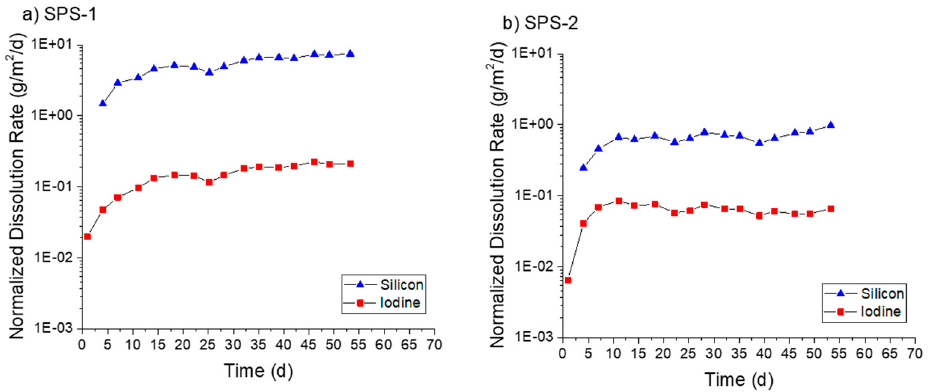
Figure 12. Normalized dissolution rates calculated from SPFT experiments using the SFA samples at pH 7 for: ( a ) SPS-1; and ( b ) SPS-2 (+20 wt % SFA). The asterisks (*) mark samplings where the flow rate deviated by >10% from the average flow of the test.